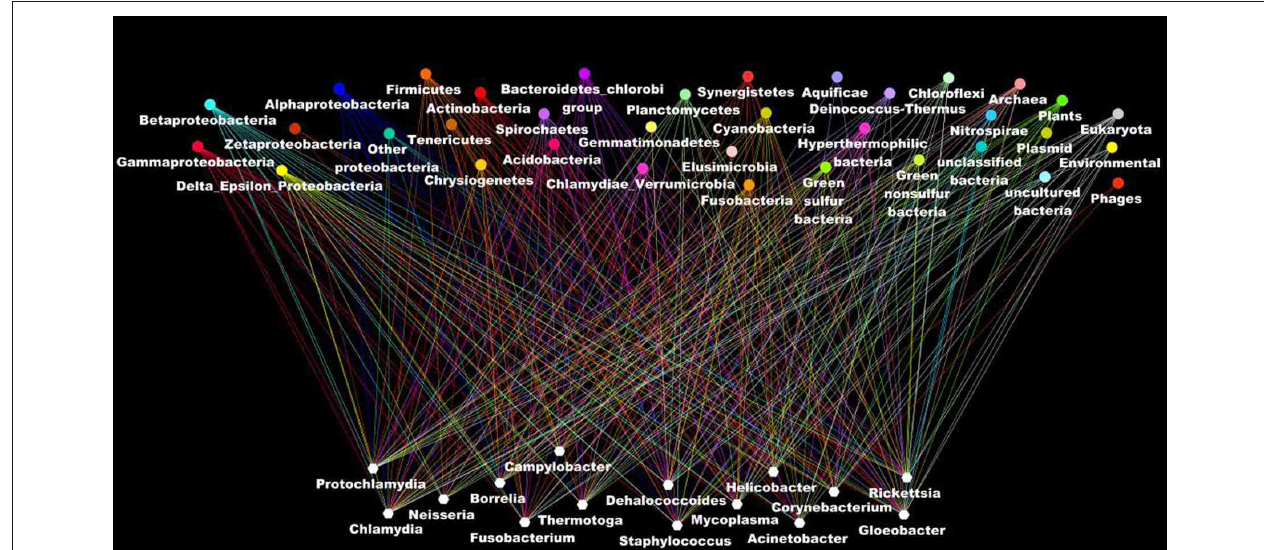
FIGURE 7 | The ascendant genealogy or the rhizome of bacteria. Bacterial genomes (at the bottom in blank) have a mosaic structure as a result of lateral inheritance from the different organisms in the different taxonomic group